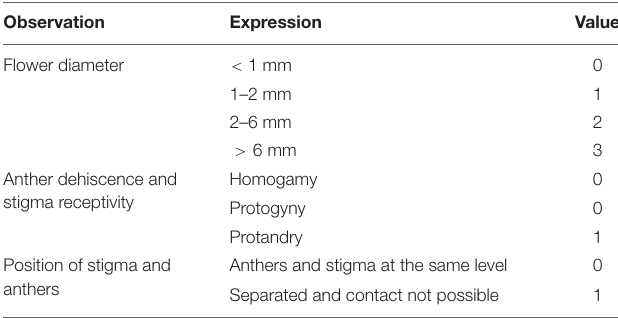
TABLE 2 | Outcrossing index value vis-a-vis type of breeding system (following Dafni, 1992). Outcrossing index